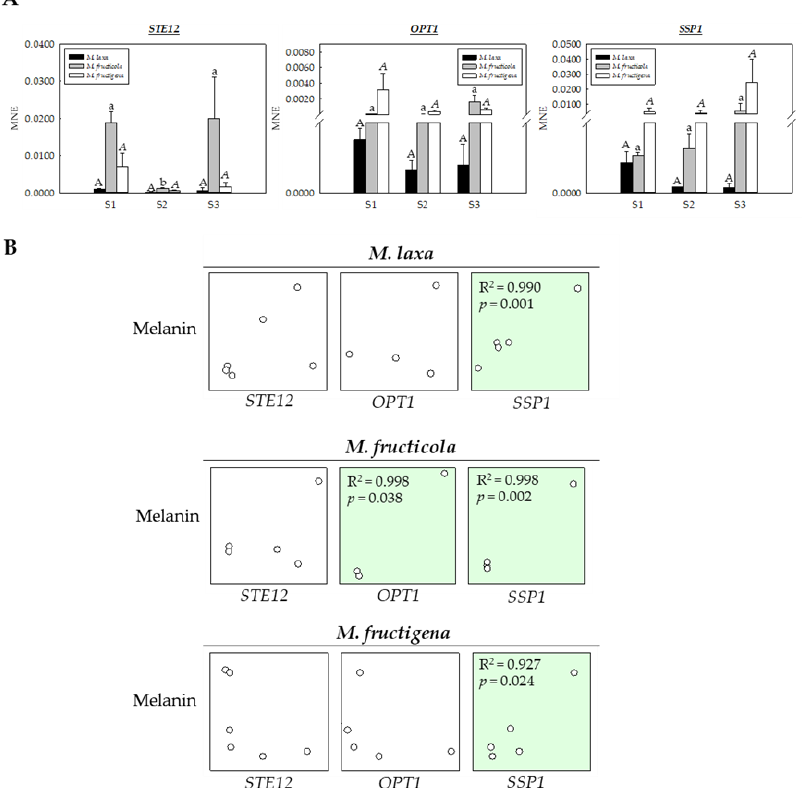
Figure 6. ( A ) Mean normalized expression (MNE) of Monilinia spp. of STE12 , OPT1 , and SSP1 genes in ‘Red Jim’ nectarines infected with M. laxa , M. fructicola and M. fructigena , at different stages of brown rot development (S1: peel surface maceration stage; S2: colonization stage; and S3: spreading stage). Different capital, lower case, and italic letters indicate significant differences ( p ≤ 0.05) between the stages of disease development for each M. laxa , M. fructicola , and M. fructigena species, respectively. Error bars represent the standard deviation of the means (n = 3). ( B ) Pearson’s product moment correlation between melanin content and STE12 , OPT1 , and SSP1 gene expression in ‘Red Jim’ nectarines. Green colors denote significant ( p ≤ 0.05) correlations.